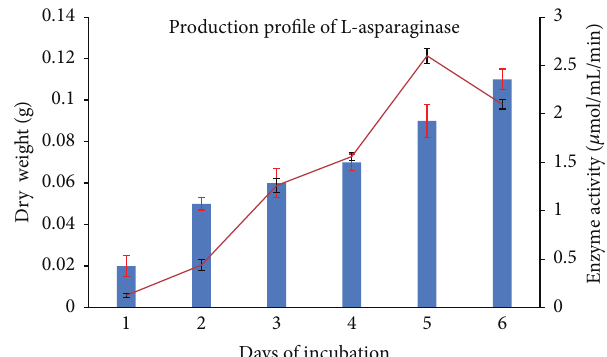
Figure 2: Production profile of L-asparaginase by Streptomyces ginsengisoli grown in asparagine dextrose salt Broth. A positive correlation between cell dry weight (bar chart) and enzyme activity (line) was observed.